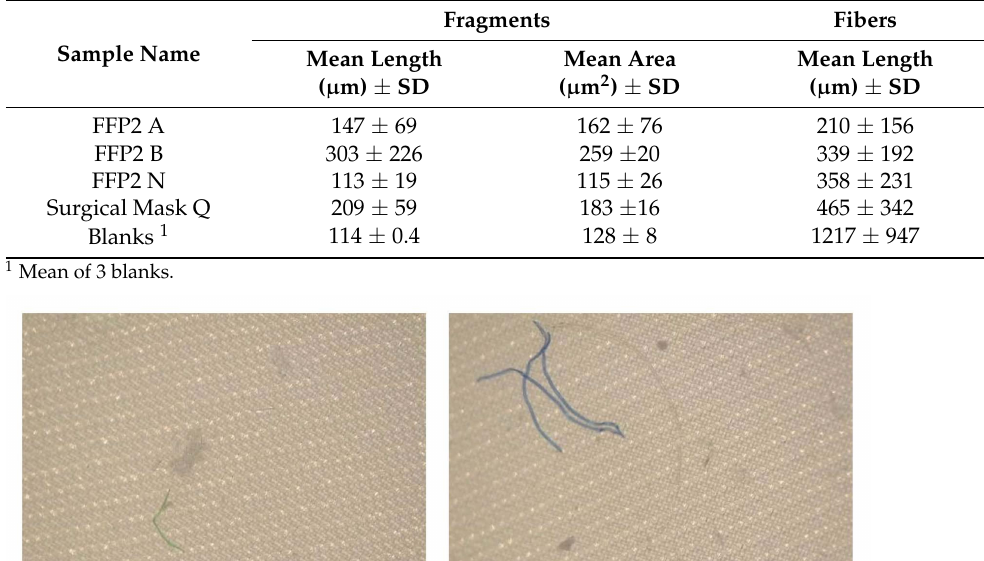
Table 4. Analysis of particles from the migration experiment (surface area 20 × 0.5 cm 2 ) indicating mean length and area of fragments and and length of fibers.